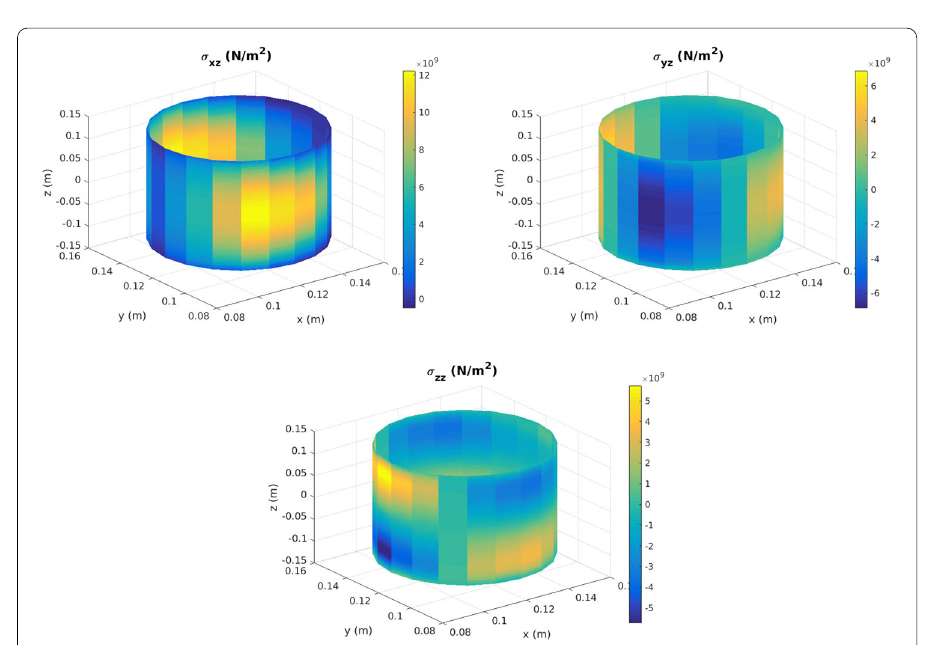
Fig. 8 Out-of-plane stress tensor components around the hole using 3D